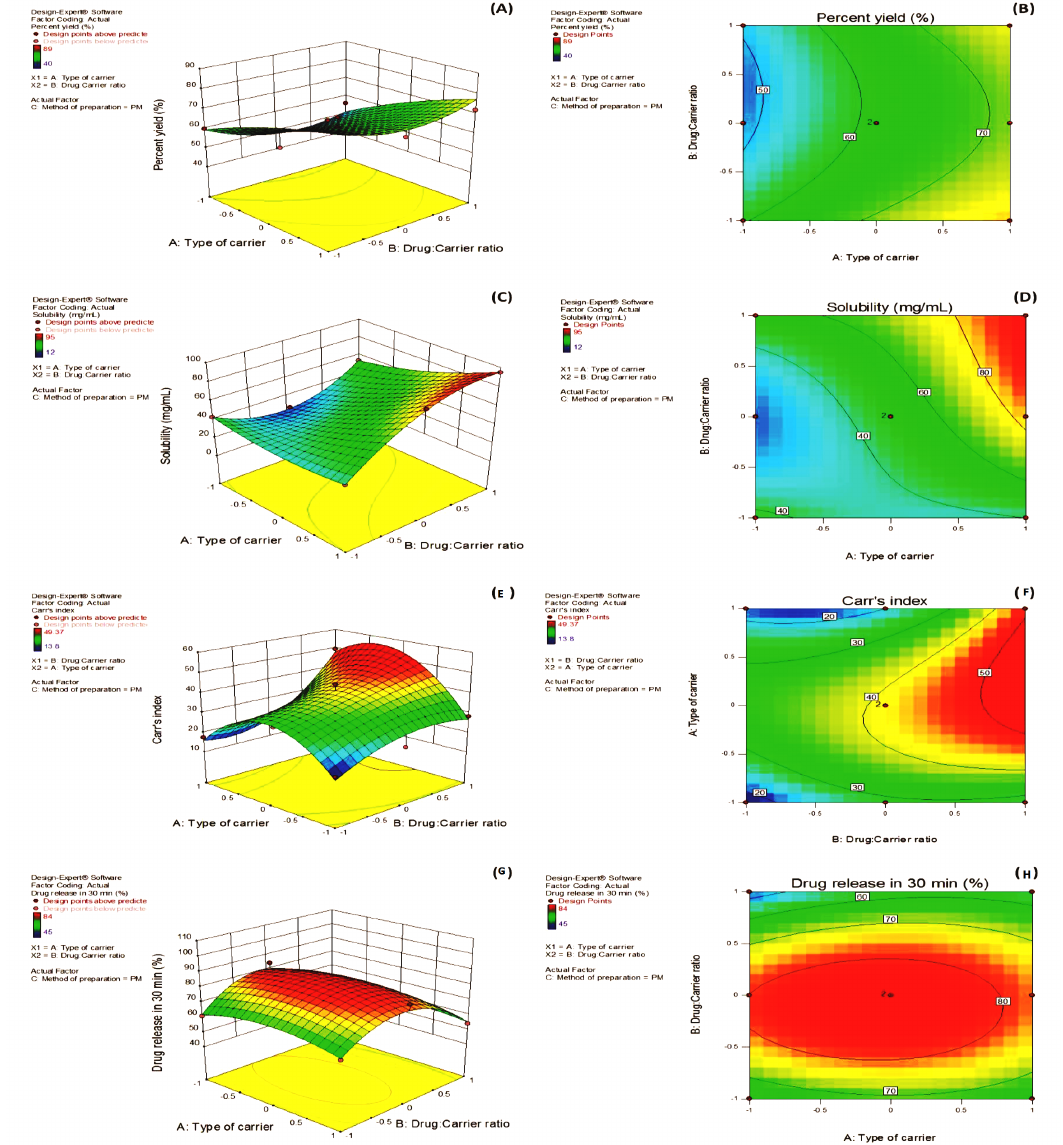
FIGURE 4 - 3D-response surface plots and 2D-contour plots between the selected factors and their effect on various response variables (A-B) percent yield, (C-D) solubility, (E-F) carr’s index, (G-H) drug release in 30